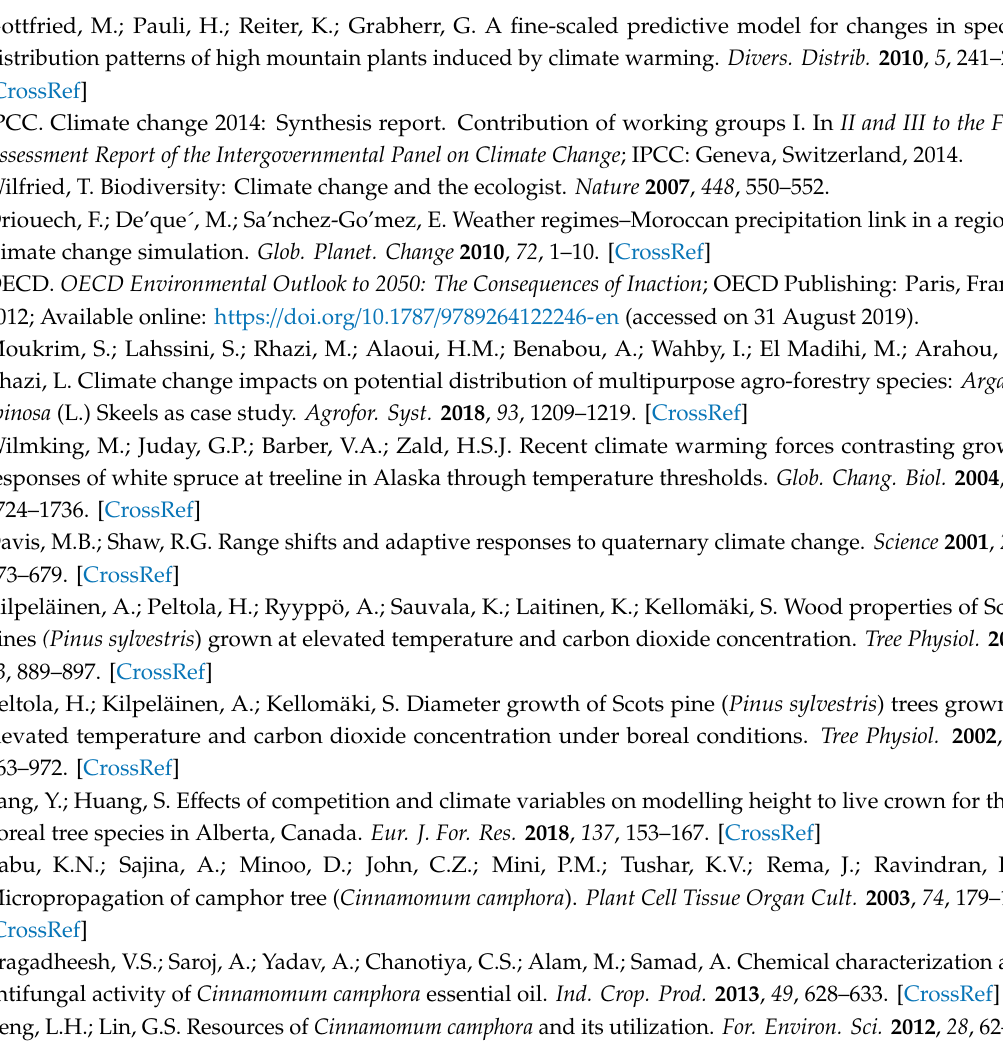
Figure A2. This picture shows the results of the jackknife test of variable importance in the camphor tree habitat distribution model. The environmental variable with highest gain when used in isolation is MAT, which therefore appears to have the most useful information by itself. Values shown are averages over replicate runs.